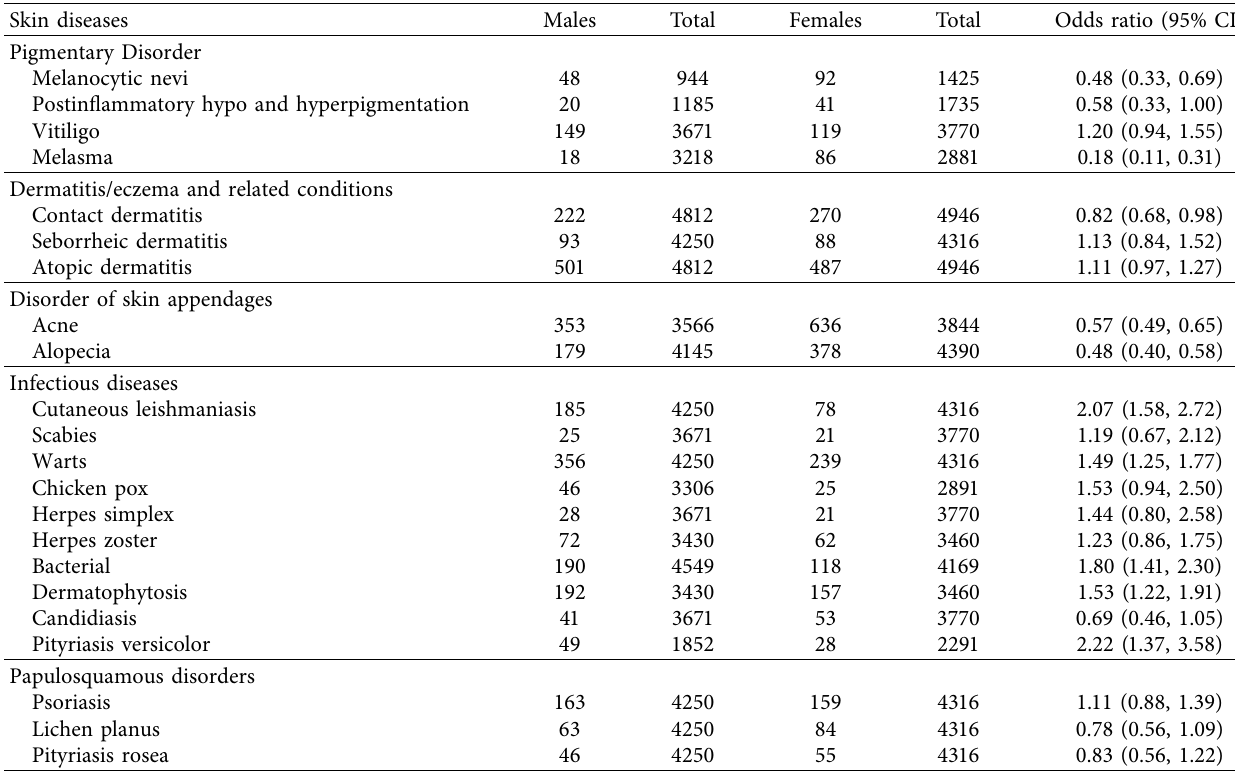
Table 4: Comparison between males and females regarding the skin diseases pattern in Saudi Arabia.